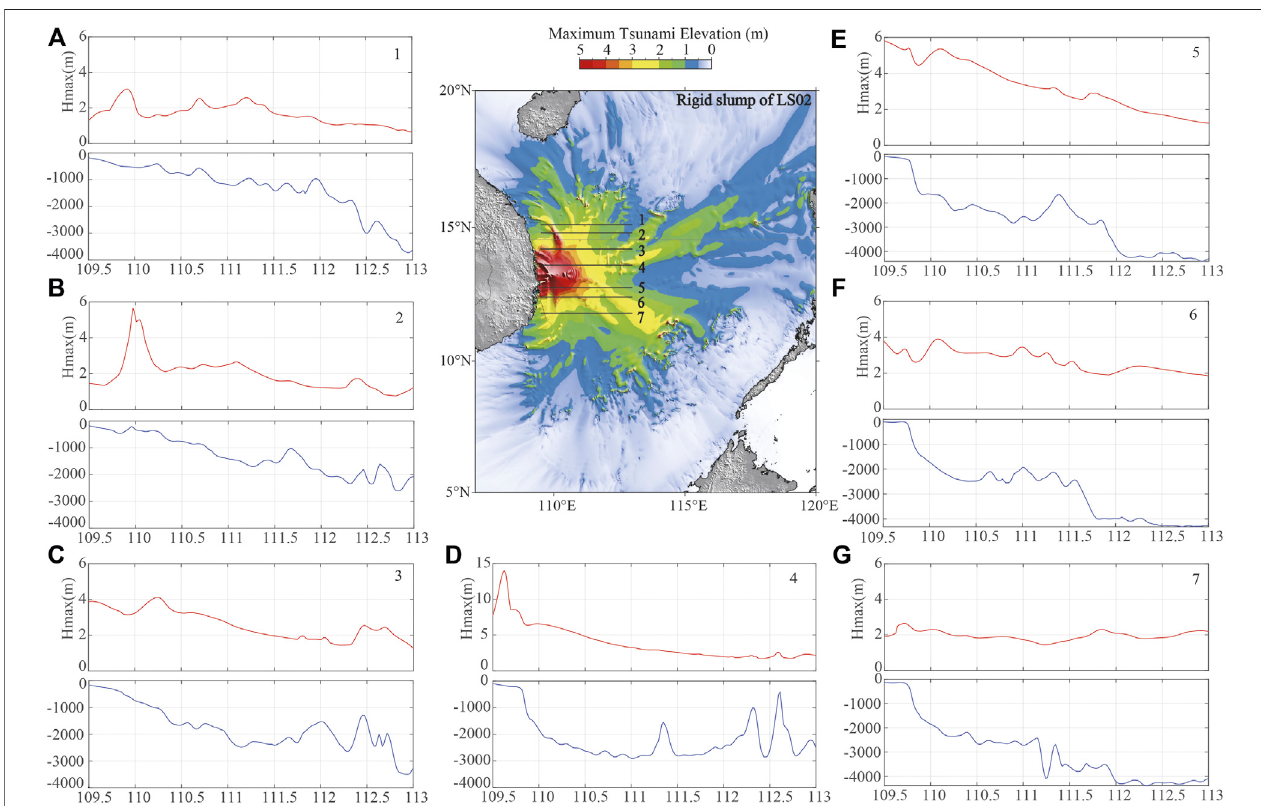
FIGURE 11 | The pro fi les of maximum surface elevation and their corresponding bathymetry along seven transects marked in the subplot in the middle.